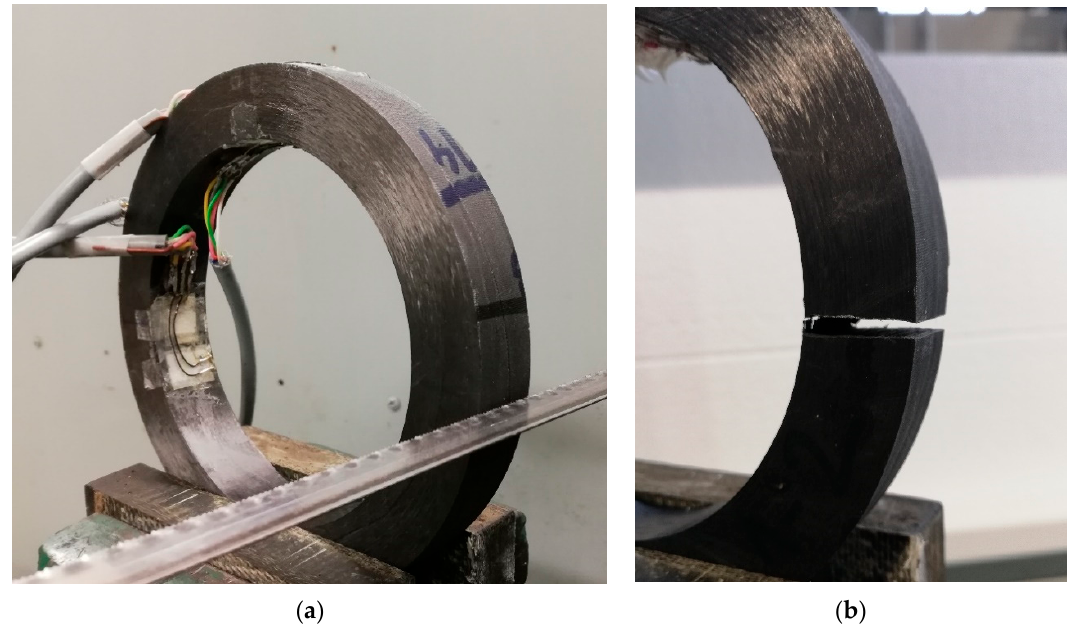
Figure 4. Photos of the tested ring: ( a ) before cutting and ( b ) after cutting.